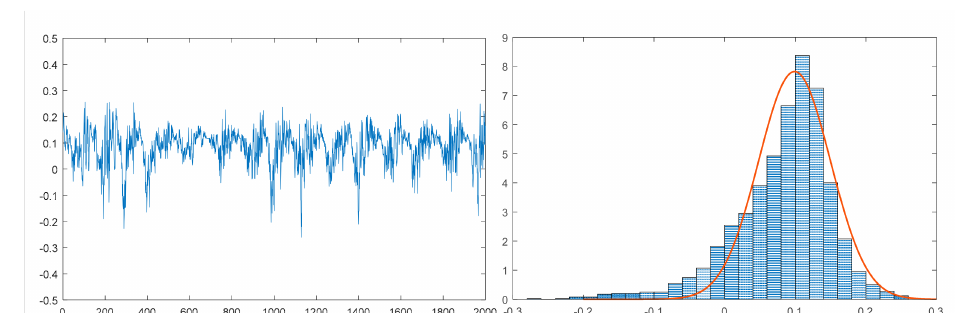
Figure 5. Error sequence generation.